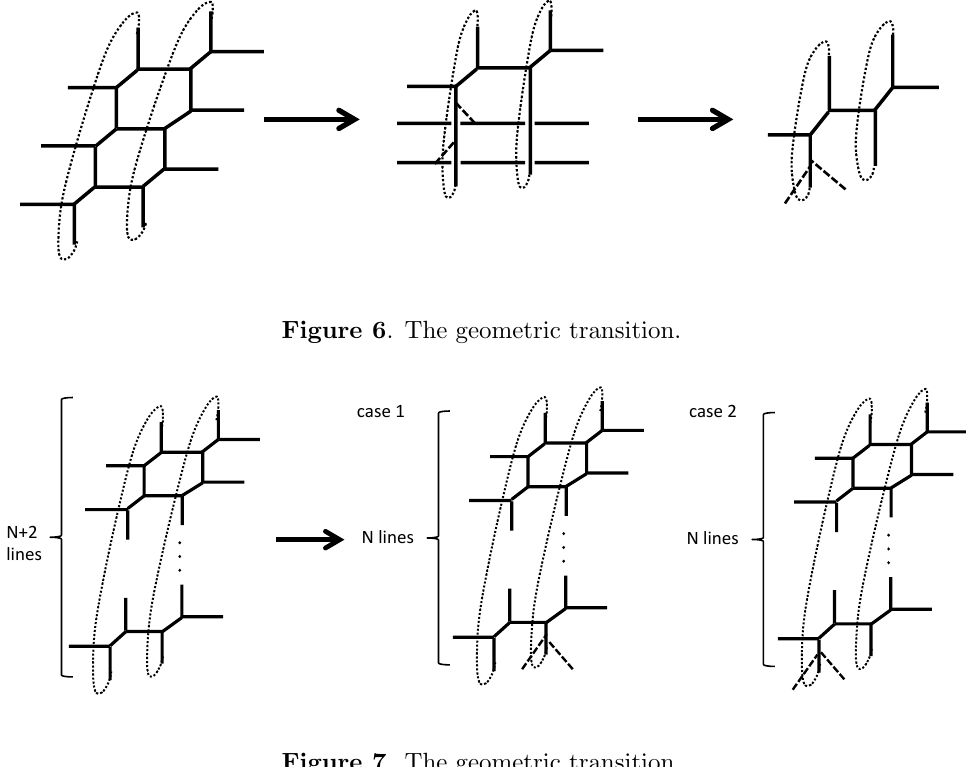
Figure 7 . The geometric